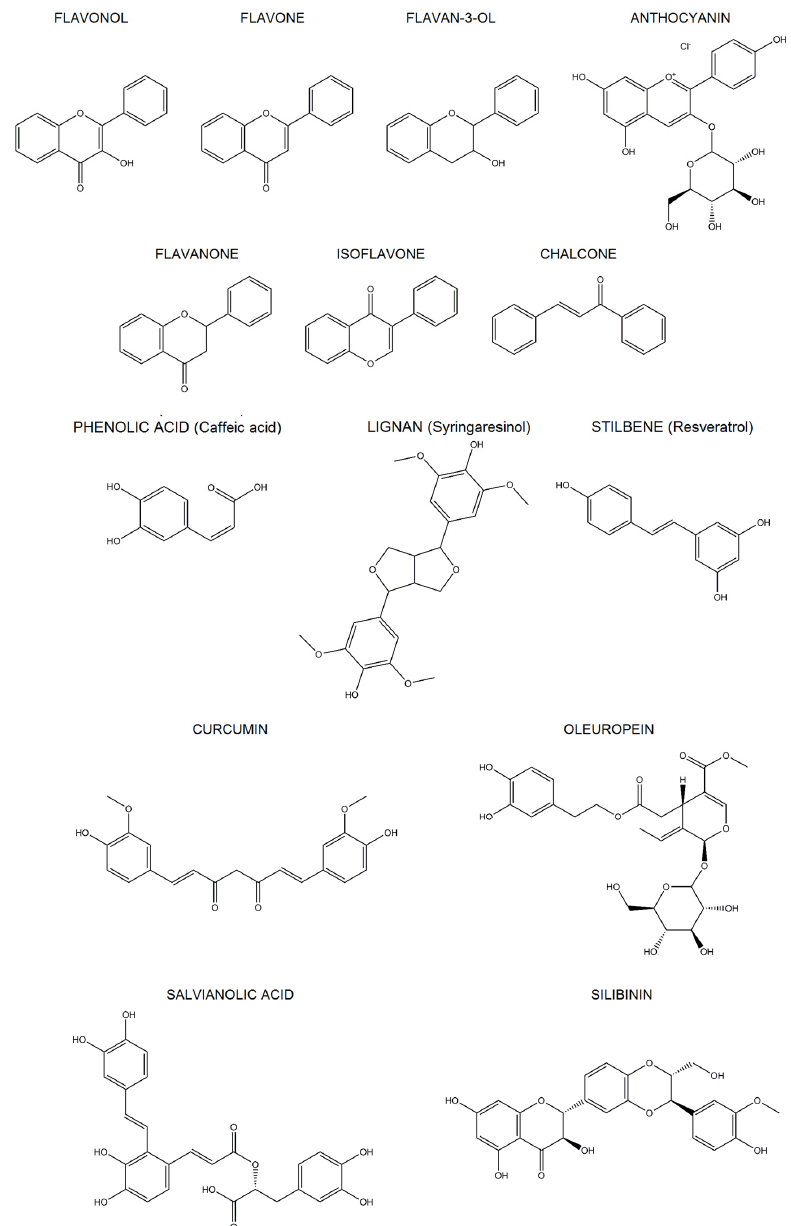
Figure 2. Chemical structure of polyphenols.